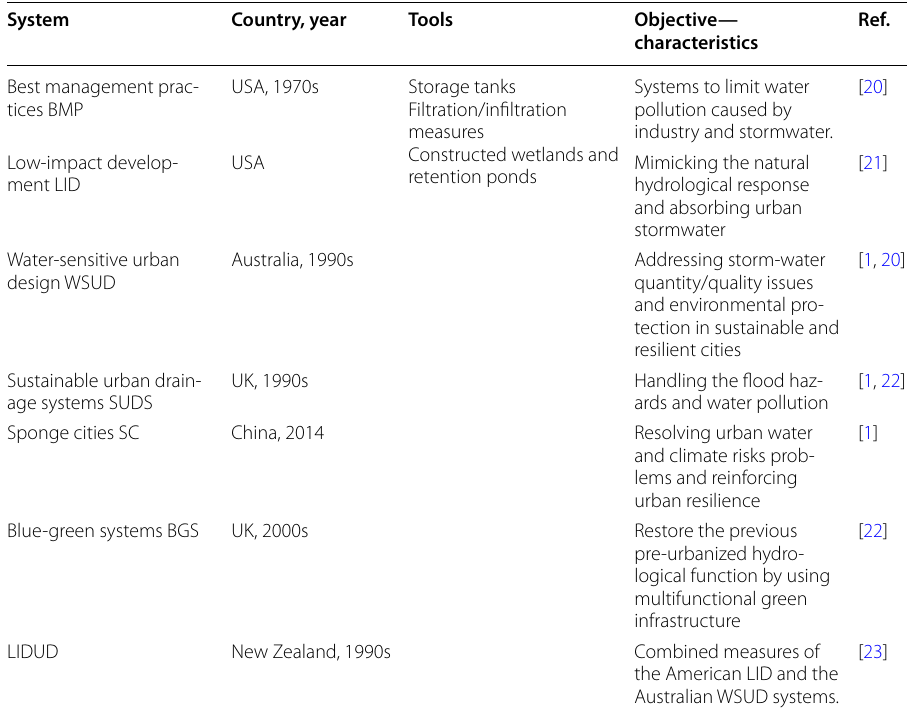
Table 4 Integrated urban water systems System Country, year Tools Objective—